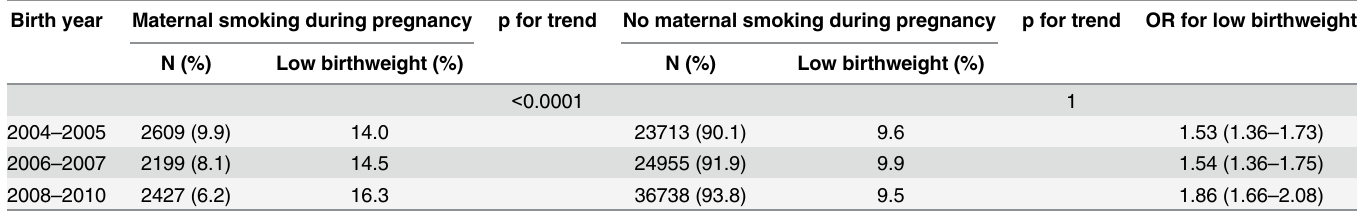
Table 2. Association between maternal smoking during pregnancy and low birthweight by birth year. Birth year